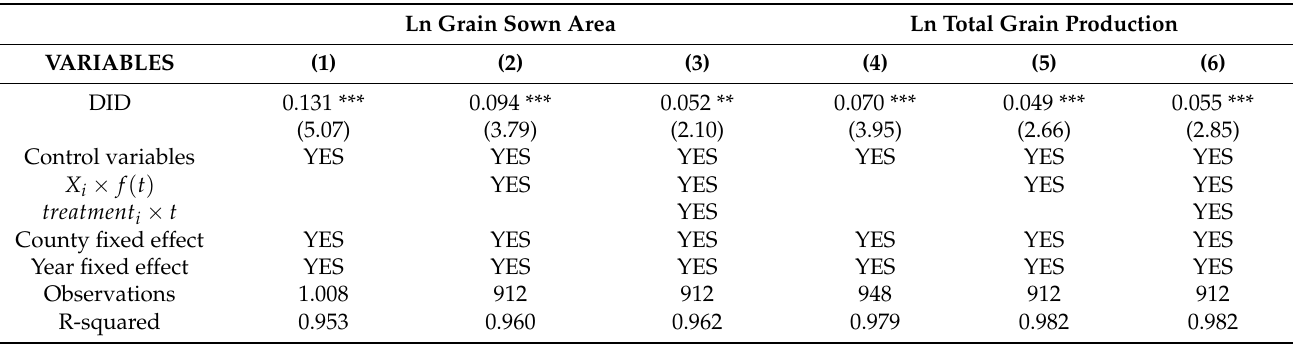
Table 3. Baseline regression